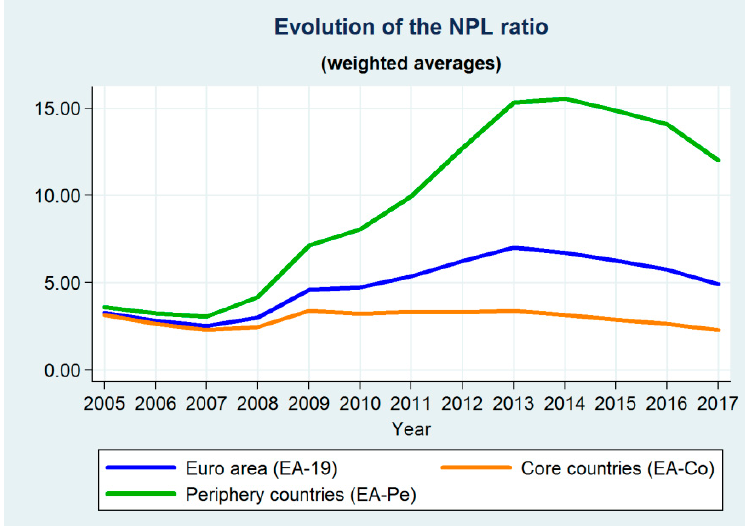
Figure 4. Evolution of the NPL ratio. Source: World Bank, own calculations.